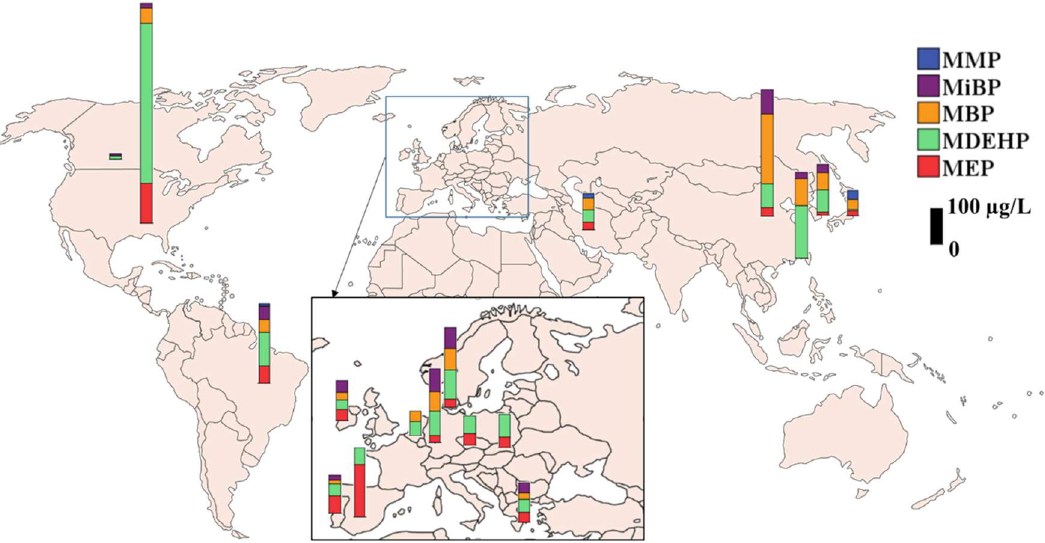
Figure 4. Urinary concentrations of phthalate metabolites reported in children (general population) from several countries (MDEHP: Sum of DEHP metabolites; biomonitoring data published after 2000, median concentration is presented).